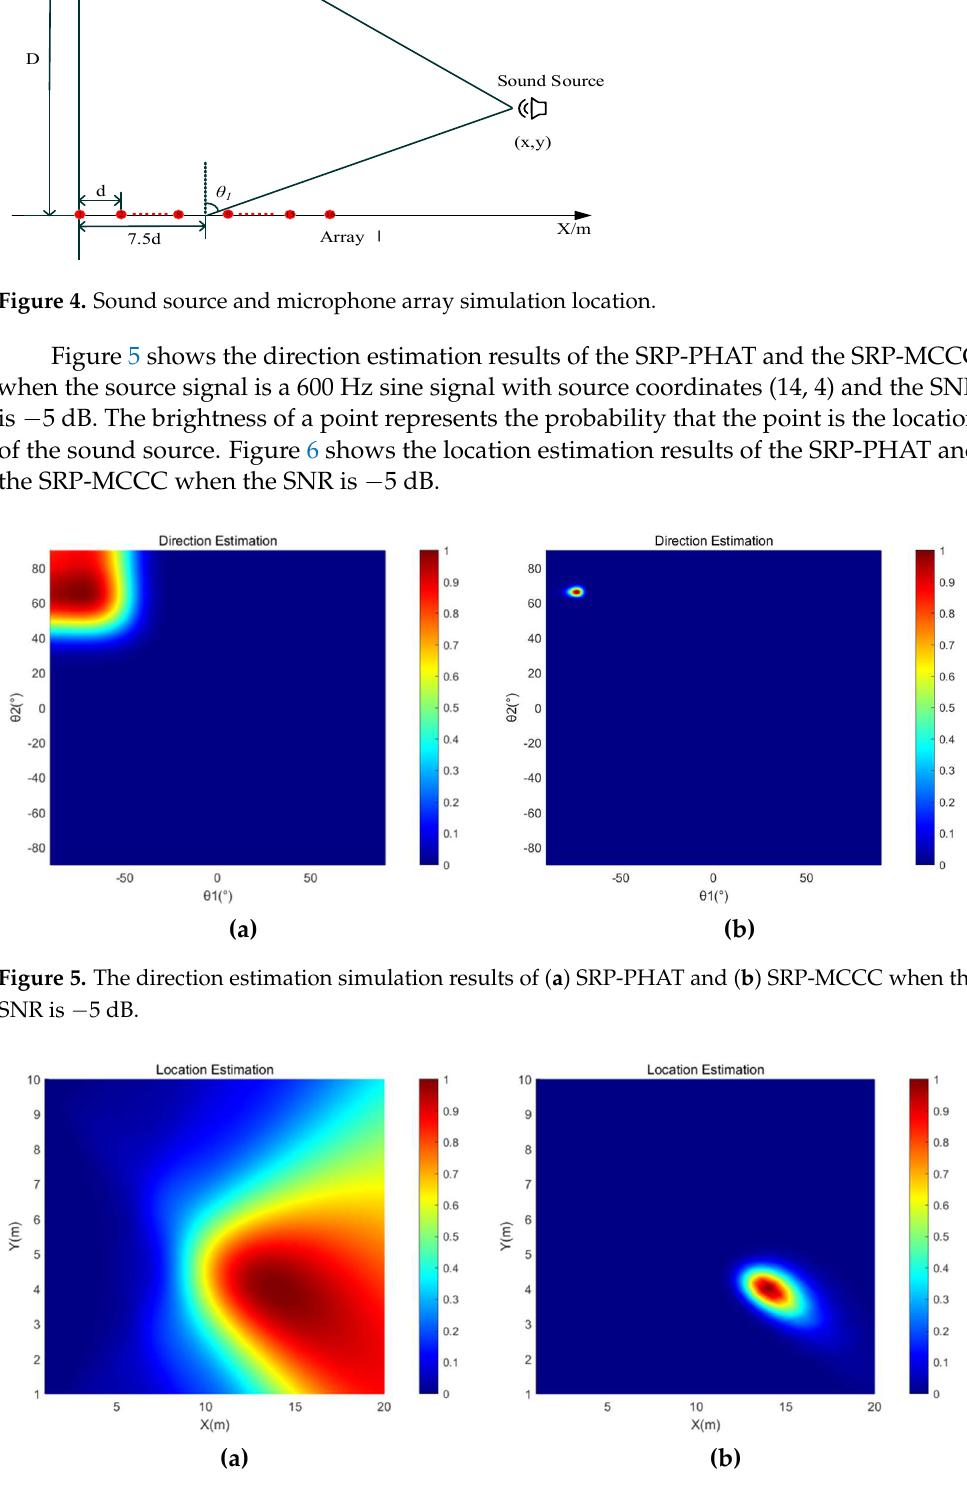
Figure 6. The location estimation simulation results of ( a ) SRP-PHAT and ( b ) SRP-MCCC when the SNR is −5 dB.